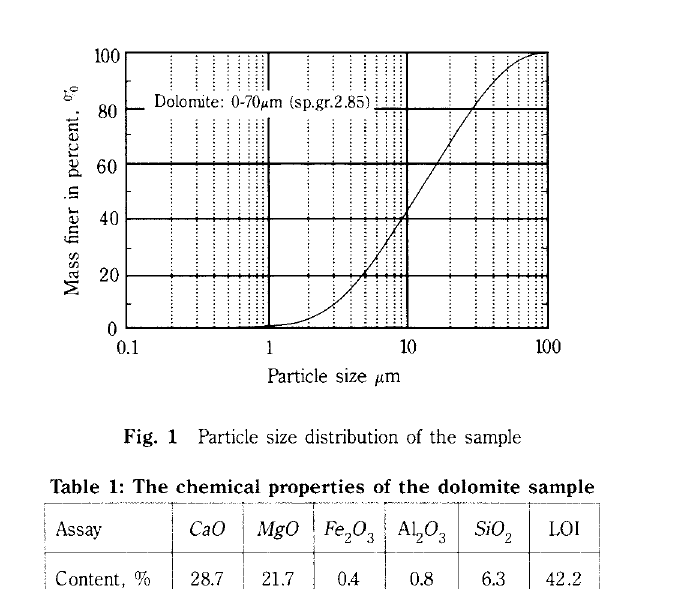
Fig. 1 Particle size distribution of the sample Table 1: The chemical properties of the dolomite sample